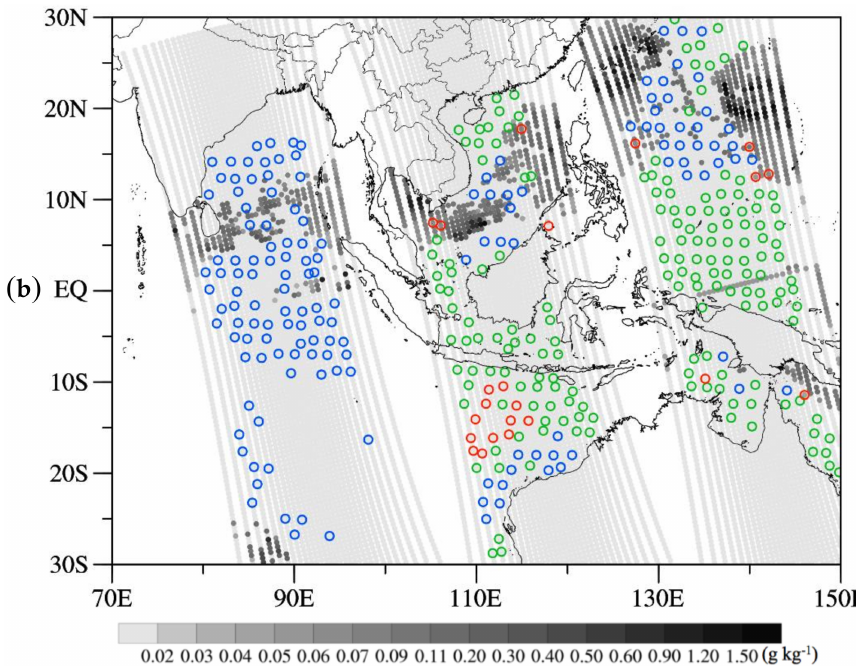
Figure 3. Spatial distribution of the data from the AMSU-A onboard the MetOp-A satellite assimilated by the GRAPES system at 0900 UTC 8 August 2019. The green circles are the data retained by both cloud detection methods, the blue circles are the data retained only by the new method and the red circles are the data retained only by the current GRAPES method. The shaded areas represent the ( a ) LWP and ( b ) IWP retrieved from the observations of the AMSU-A and MHS onboard the MetOp-A satellite during the time period 0900–1500 UTC 8 August